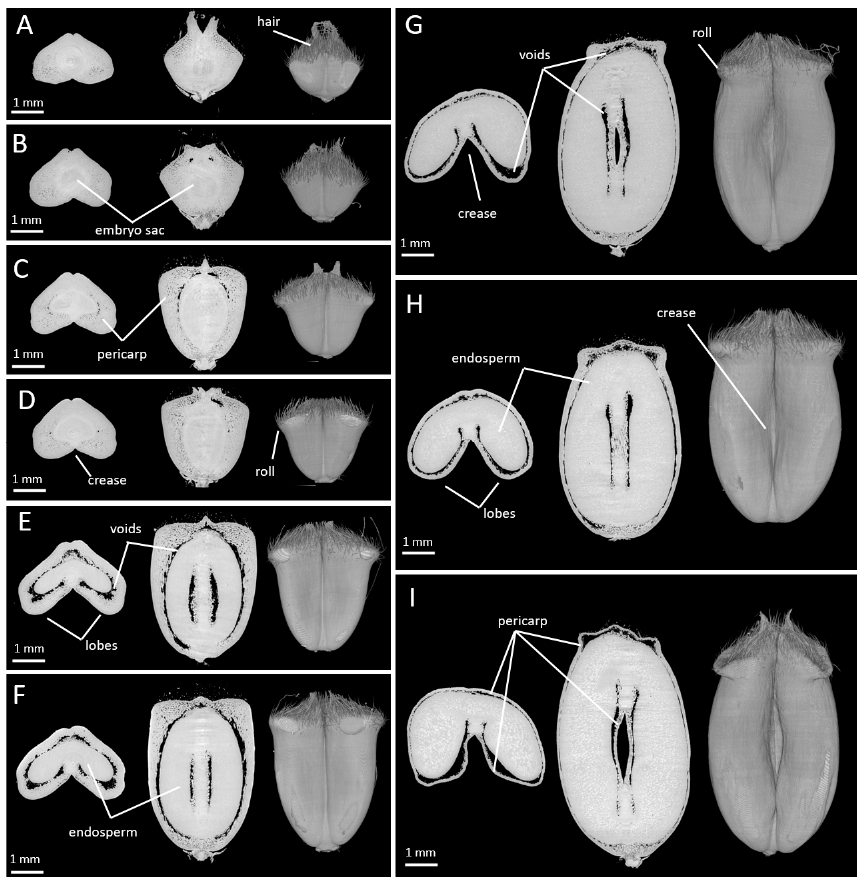
Figure 1. Representative X-Ray tomography images obtained with low resolution for wheat cary- opses at stage 0 to 250 °DAA. 0 °DAA ( A ), 25 °DAA ( B ), 50 °DAA ( C ), 80 °DAA ( D ), 100 °DAA ( E ), 150 °DAA ( F ), 180 °DAA ( G ), 200 °DAA ( H ), 250 °DAA ( I ). For each stage, from left to right, exam- ples of virtual cross and longitudinal sections sampled from the 3D caryopsis reconstruction. Low-resolution images of virtual cross-sections localized at different positions along the longitudinal axis of caryopses (Figure 2A) highlighted spatial variability in the tissue composition. For instance, at stage 50 °DAA at the bottom position, the caryopsis con- tained pericarp and vascular tissues; at the middle position, the space was mainly occu- pied by the embryo sac and a thick mesocarp, while the very top contained only pericarp tissues (Figure 2B). At stage 250 °DAA at the bottom position, the caryopsis contained